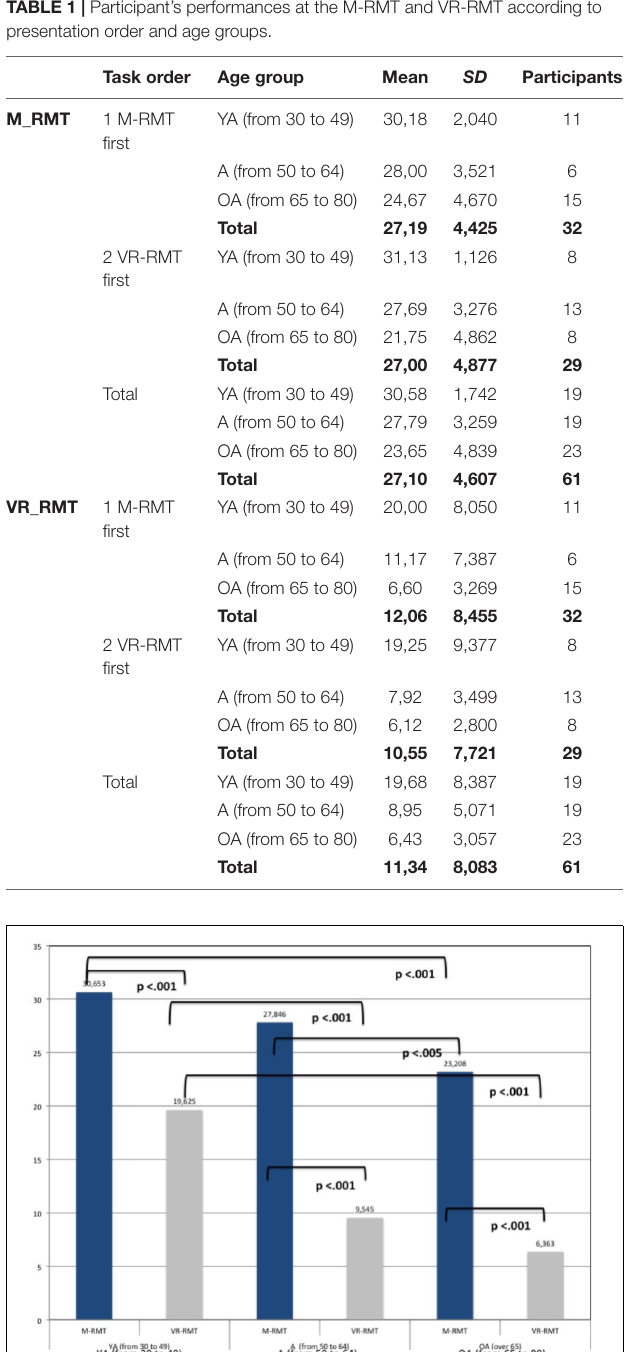
FIGURE 2 | Differences in M_RMT and VR-RMT for age